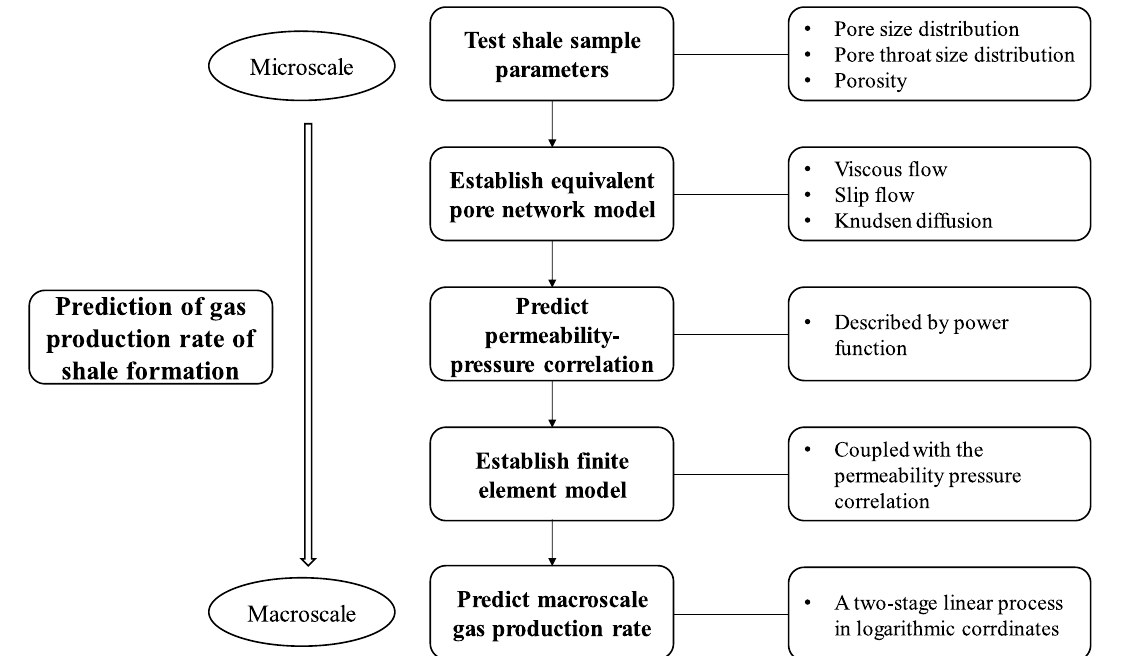
Figure 8. The flowchart of the micro–macro methodology to predict the gas production rate of shale